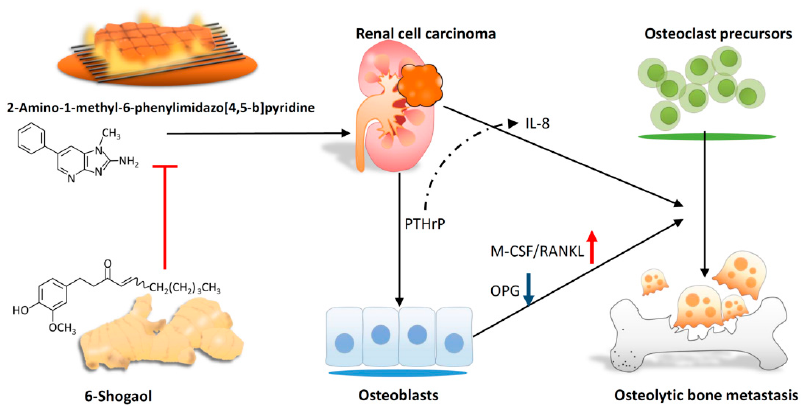
Figure 7. Scheme of proposed 6-shogaol-inhibited PhIP-induced human renal cell carcinoma bone metastasis.